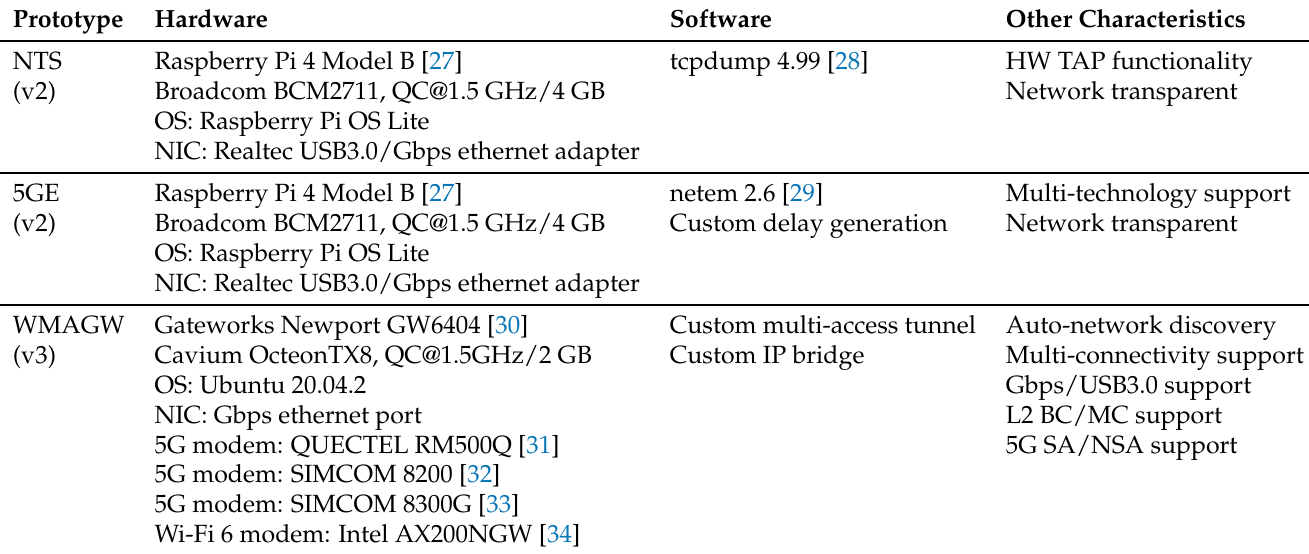
Table 1. Summary of main hardware and software components, and other relevant characteristics for the different prototyping